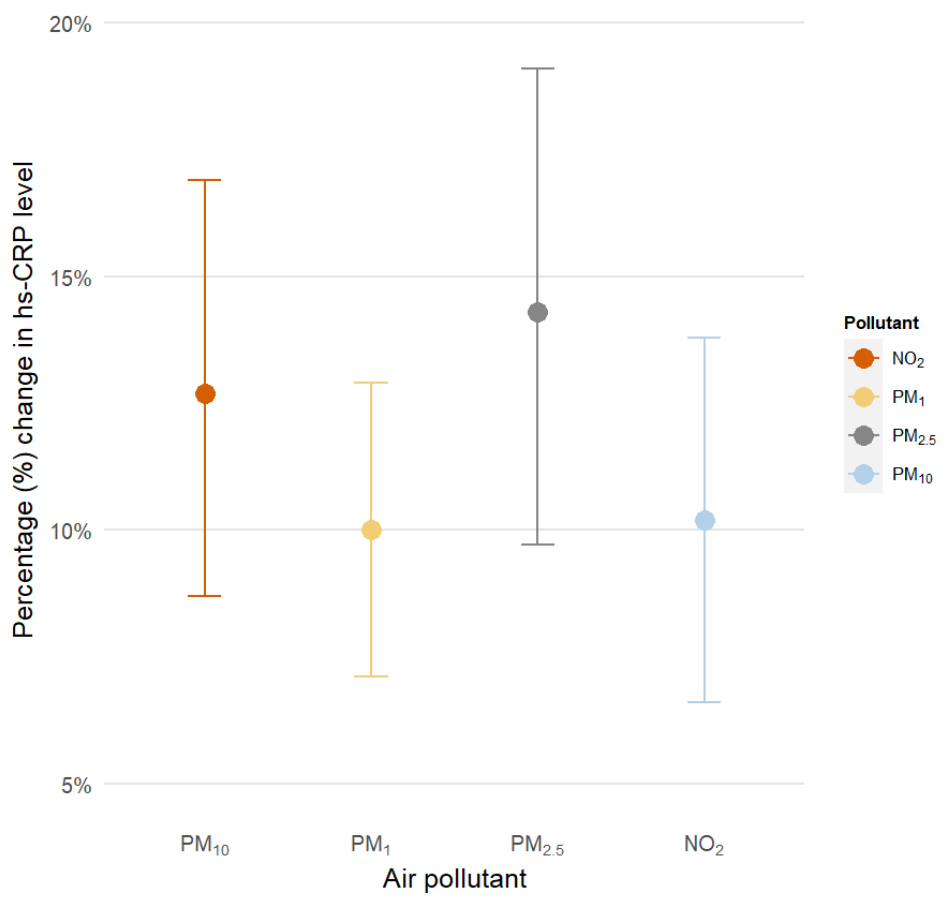
Figure 2. Percentage change (95% confidence interval (CI)) in high-sensitivity C reactive protein (hs-CRP) levels associated with 10 µ g/m 3 increase in 3 year moving averages of air pollution. PM 10 = particulate matter with a diameter of 10 µ m or less, PM 2.5 = with a diameter of 2.5 µ m or less, PM 1 = particulate matter with a diameter of 1 µ m or less, NO 2 = nitrogen dioxide. Models were adjusted for age, sex, BMI, tobacco use, physical activity, education level, fruit and vegetable intake, alcohol use, type of fuel used at home, median household income, and location of residence (urban/rural).